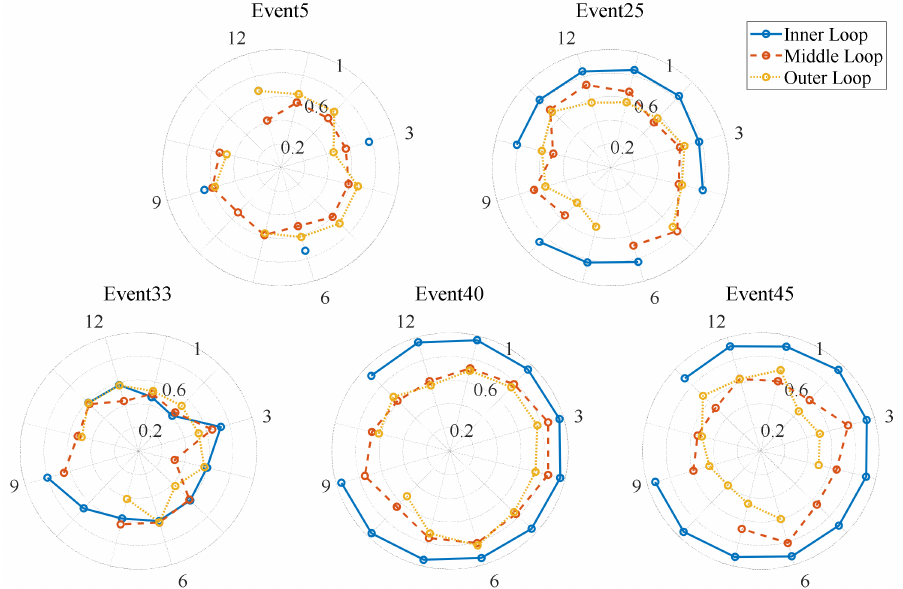
Figure 3. Energy spectra similarities between the loop stations and the center station; polar plots for the E-W